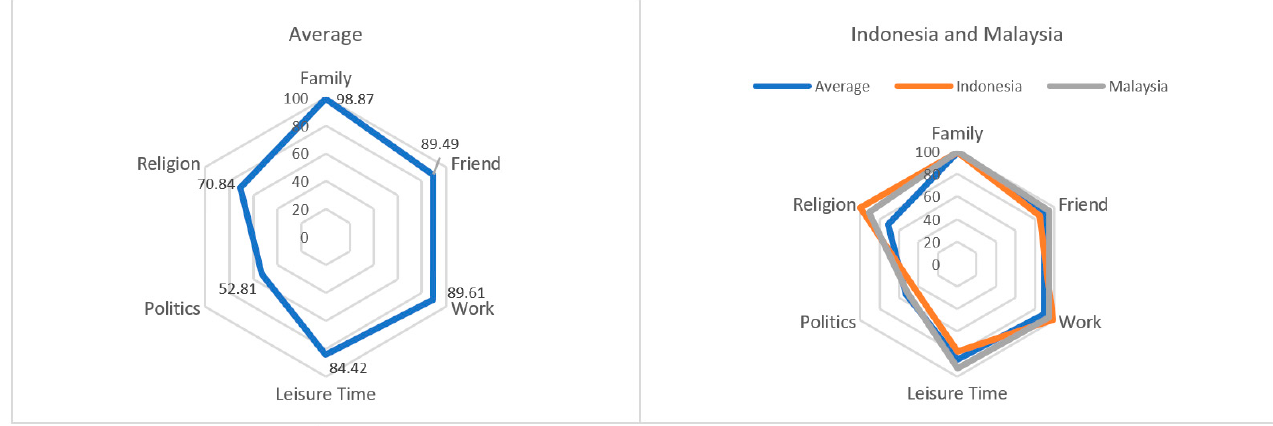
Figure 1. Important values in life by Indonesia and Malaysia. Note: The average value is counted from ten countries, i.e., Indonesia, Malaysia, Iran, Pakistan, Nigeria, Brazil, China, United States, Germany and Australia. All values are in percentage.